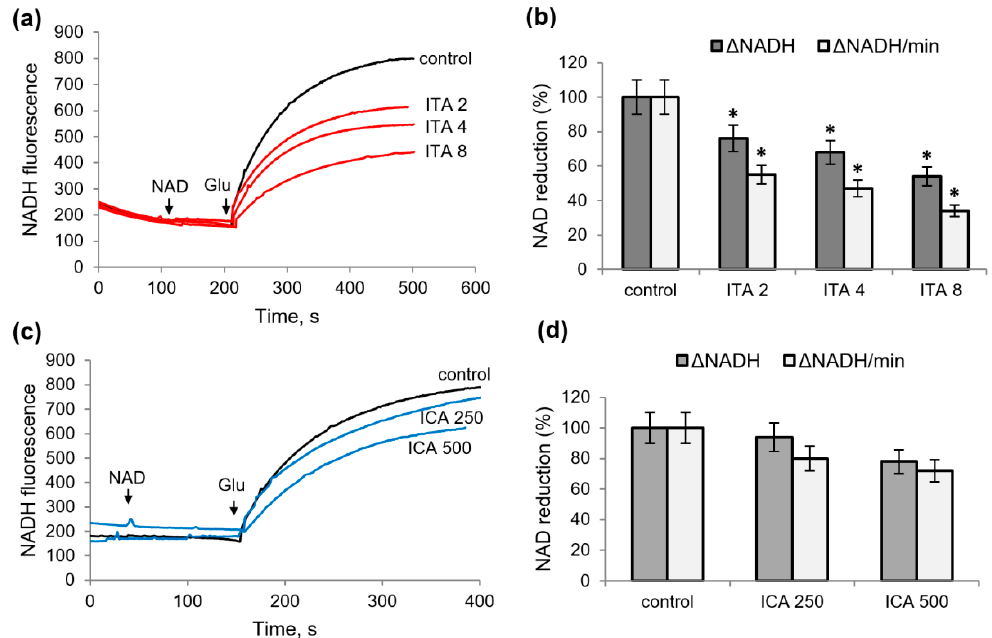
Figure 4. Influence of itaconic and indolcaboxylic acids on the reduction of NAD by glutamate in permeabilized mitochondria. Influence of ITA on the reduction of NAD (0.5 mM) ( a ) and the amplitudes and rates of NAD reduction ( b ) by glutamate; influence of ICA on the reduction of NAD (0.5 mM) ( c ) and the amplitudes and rates of NAD reduction ( d ) by glutamate. Asterisks (*) indicate values that differ significantly from the control values ( p < 0.05).